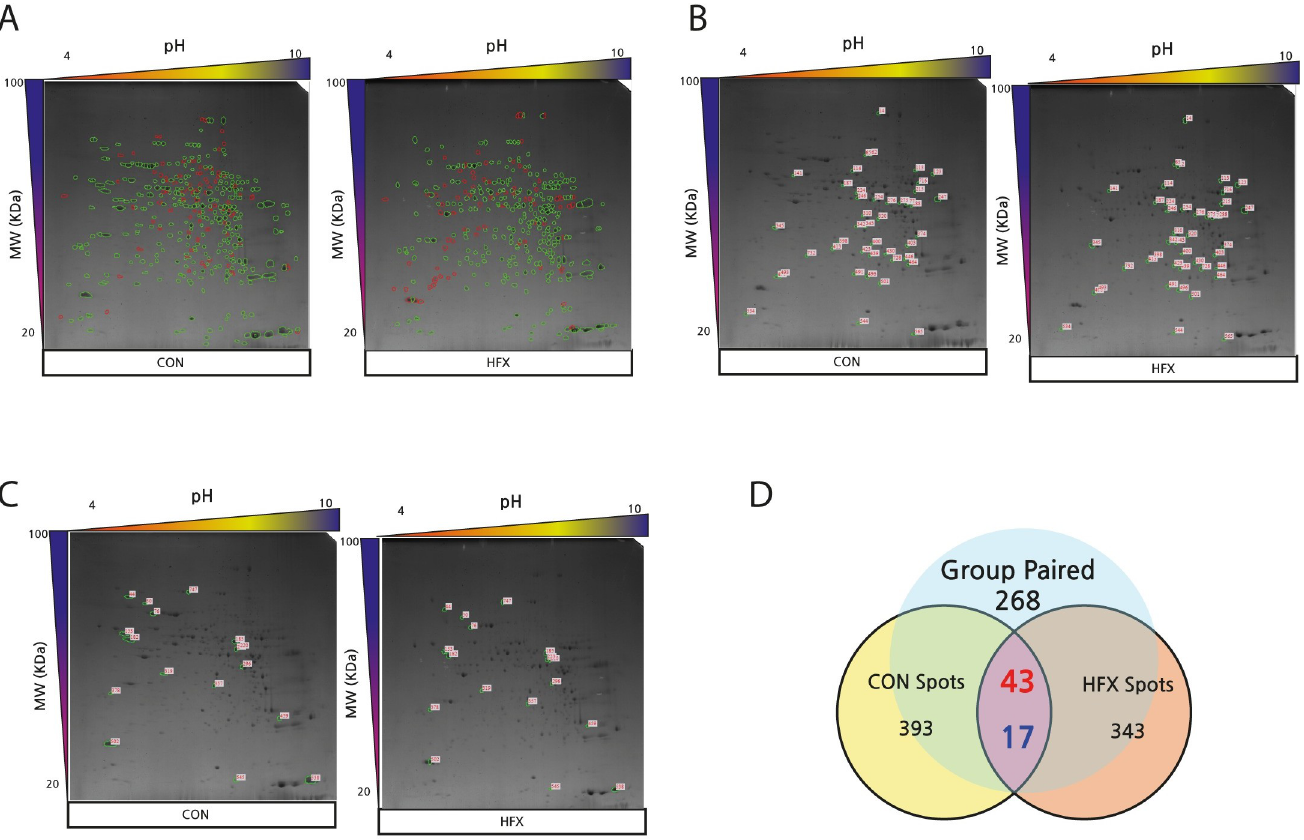
Fig 3. 2D-PAGE images and Venn diagram showing differential protein expression ( > 2-fold) between CON and HFX (A-D). (A) The images of 2D-PAGE show green circles which indicate group paired spots, and red circles that indicate group non-paired spots. Green circles indicate group paired spots, and orange circles indicate group non-paired spots. The images of the 2D-PAGE show an increase of 43 spots (B) and a decrease of 17 spots (C) among the 268 paired spots in HFD compared to CON. The differentially expressed spots showed a difference of > 2.0-fold. (D) The numbers in red denote upregulated spots and the numbers in blue indicate downregulated spots, in the Venn